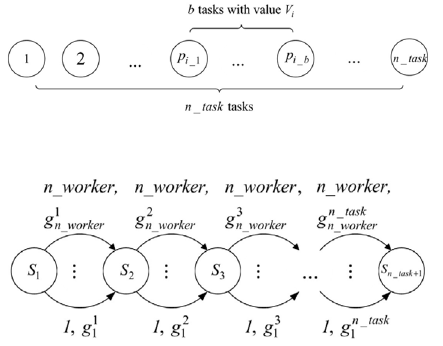
Figure 2. Task allocation state transition